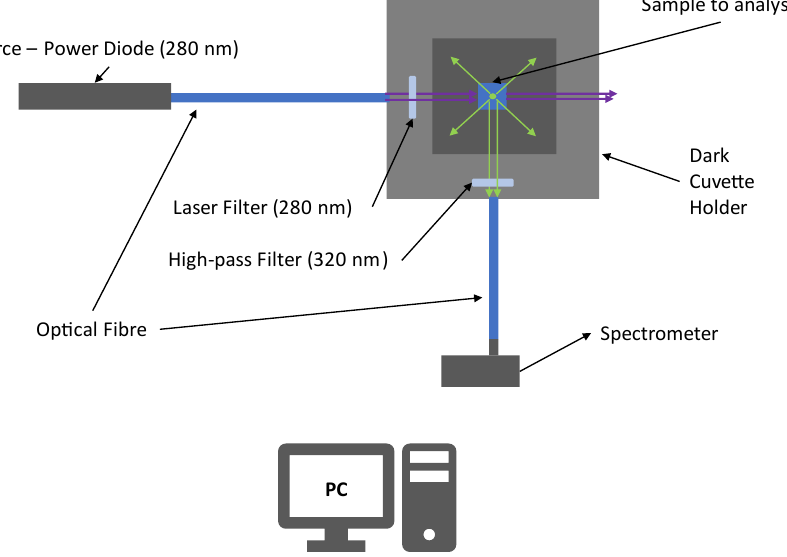
Figure 6. Experimental apparatus for preliminary tests of LIF classification and measurements using the supposed algorithms.